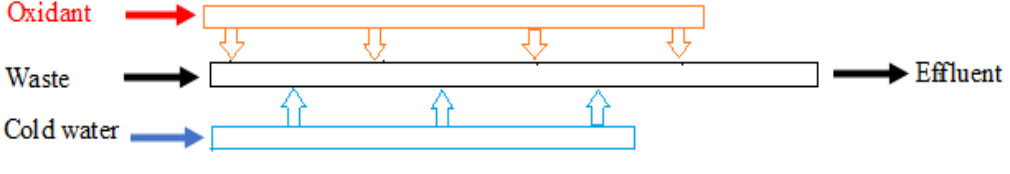
Figure 11. Tubular Chematur type reactor [85].